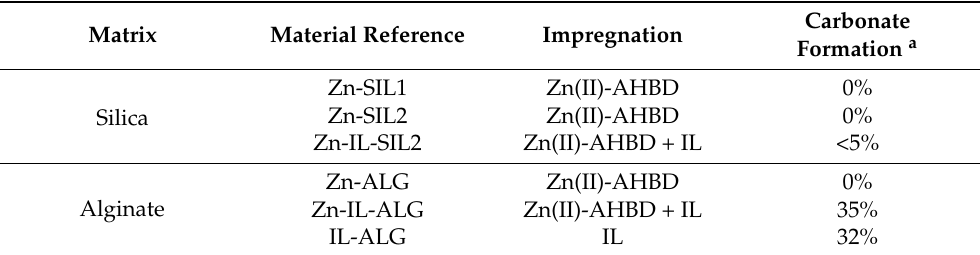
Table 3. Limonene carbonate formation after 48 h at 353.2 K and 4 MPa, using 1 mL of limonene oxide and different impregnated aerogels as catalyst